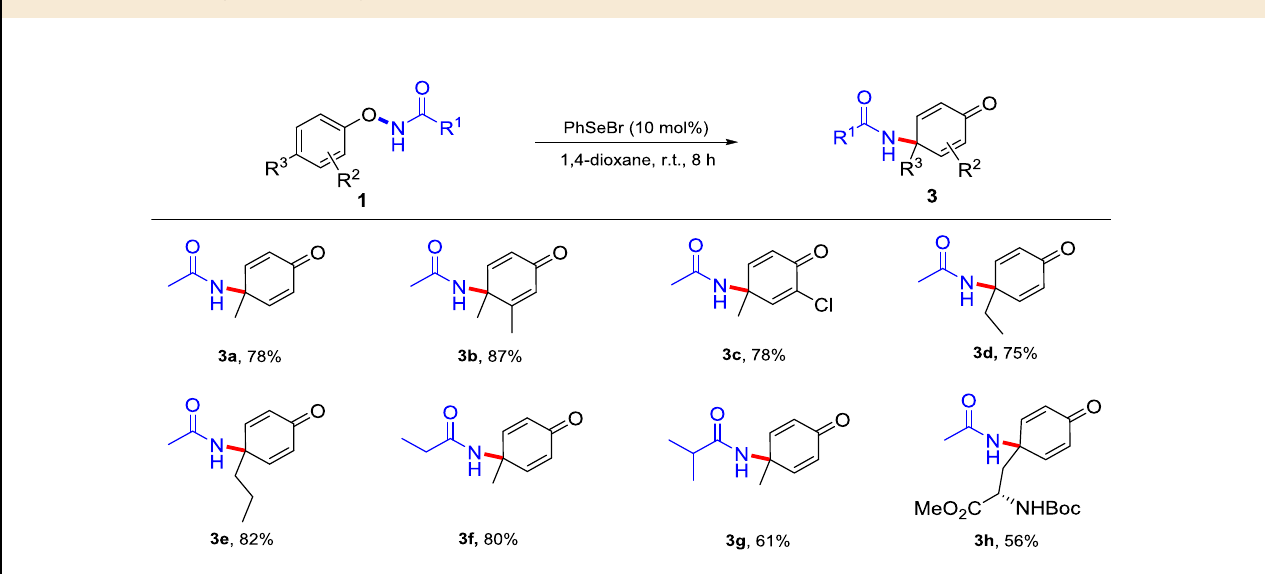
Table 2 Substrate scope of Se-catalysed dearomatization reaction